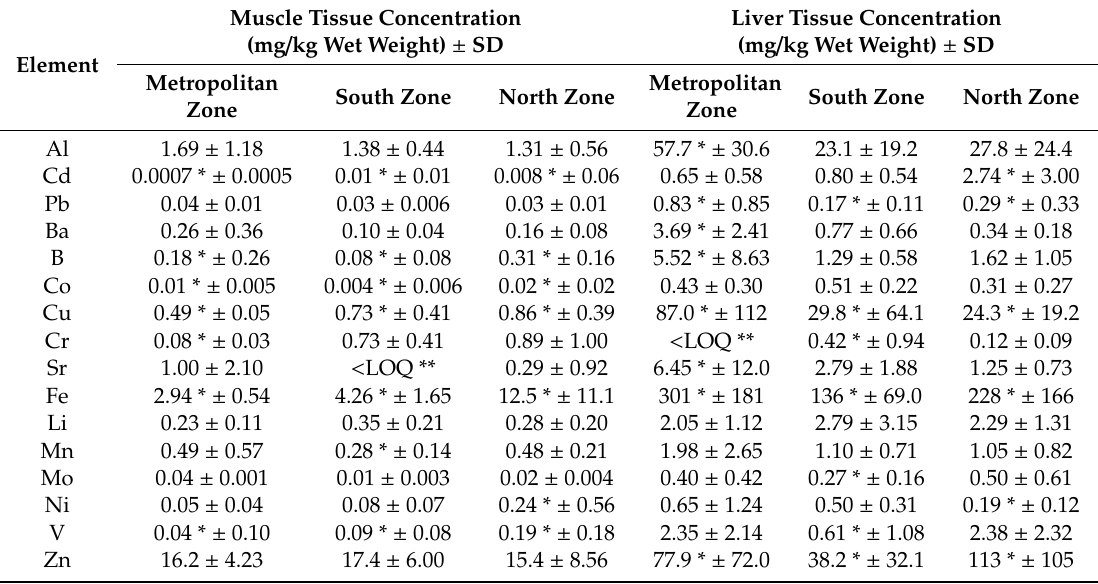
Table 4. Mean concentration (mg / kg wet weight) and standard deviations (SD) of the toxic metals and trace elements in the analyzed muscle and liver tissue according to